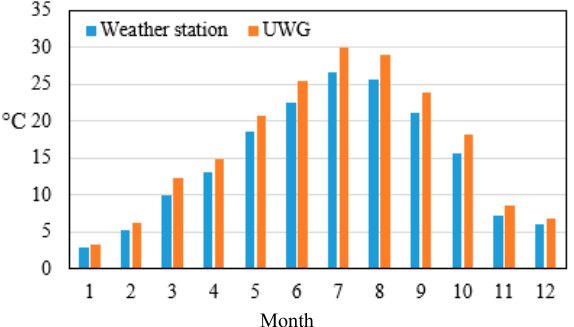
Figure 4. Localized monthly average based on hourly temperature.